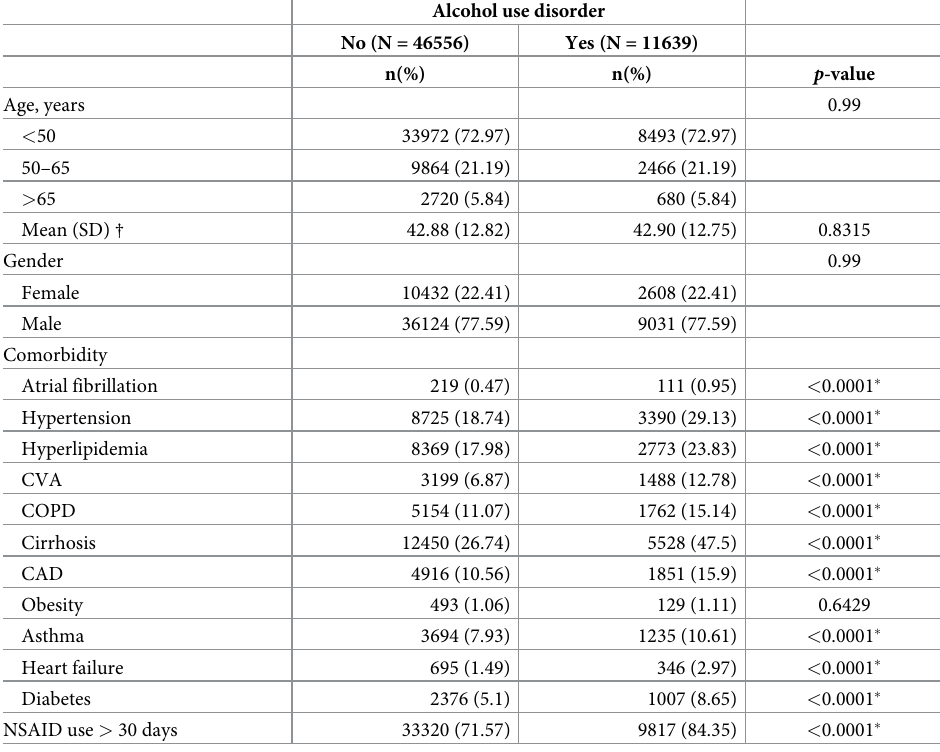
Table 1. Comparison of demographics and comorbidity between alcohol use disorder patients and the control